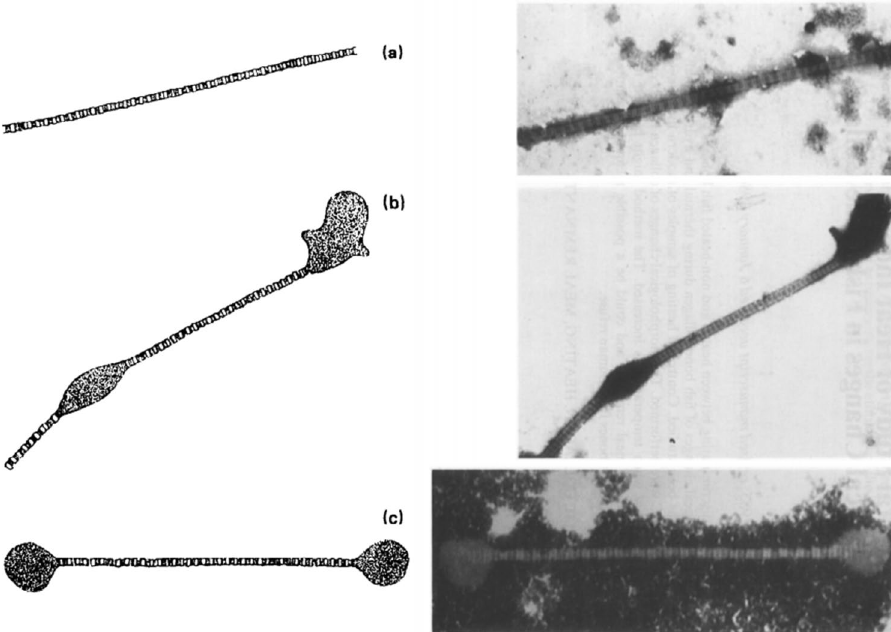
Figure 1. Collagen classification categories from Richter 20 : unaltered ( a ), beaded ( b ), and dumbbell ( c ). Reprinted from Journal of Archaeological Science, Vol 13, J Richter, Experimental study of heat induced morphological changes in fish bone collagen, 477–481, (1986), with permission from